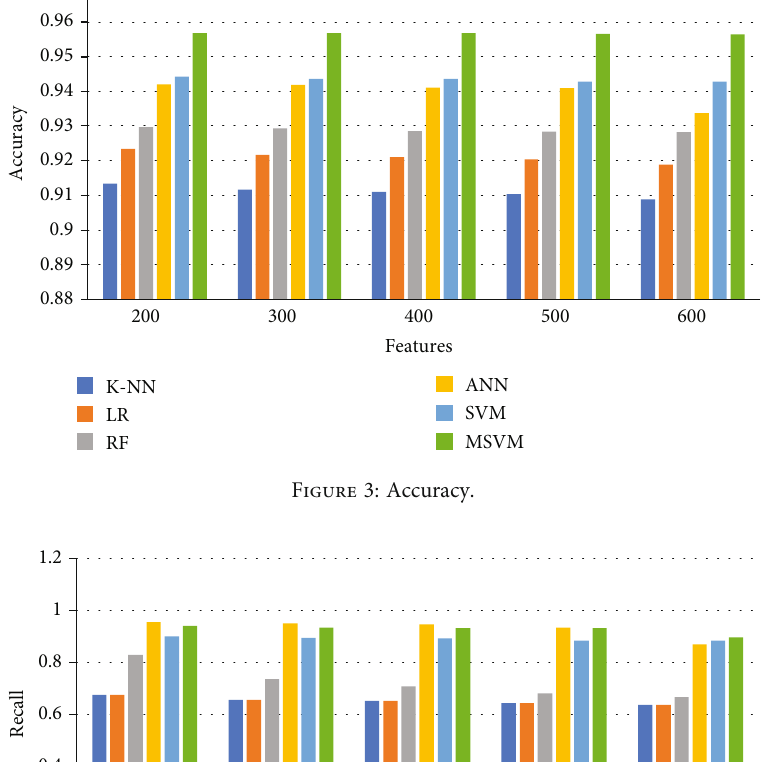
Figure 2: Precision.